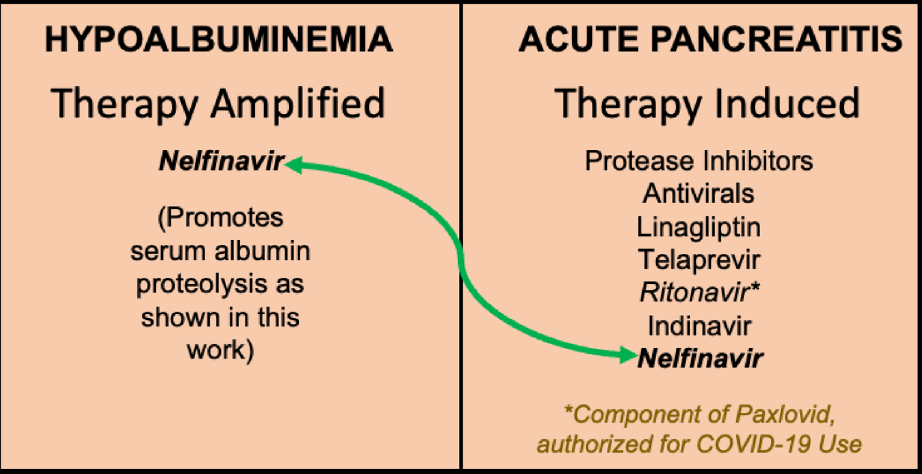
Figure 4. The work presented here demonstrates that therapies may initiate and/or amplify hypoalbuminemia, a leading indicator for severity for multiple disease states. In parallel, hundreds of therapies are known to induce acute pancreatitis, with putative protease inhibitors and antivirals over-represented. The need for early-stage screening for “ off target, ” detrimental, drug effects is apparent, though currently limited.